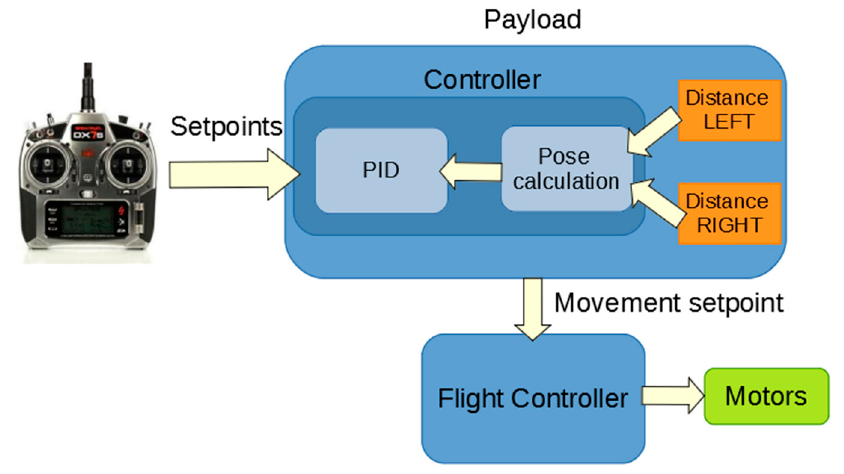
Figure 2. Control Figure 2. Control diagram. Figure 2. Control diagram.